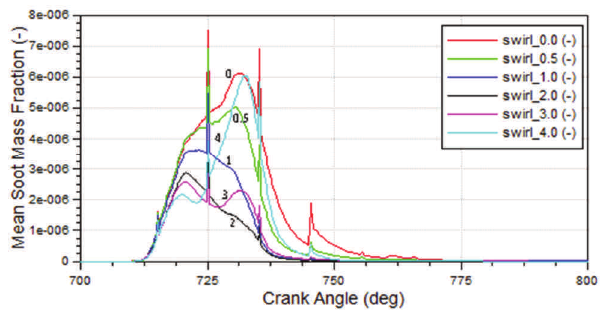
Fig. 10. Mean soot mass fraction in respect to the crank angle for different swirl ratios